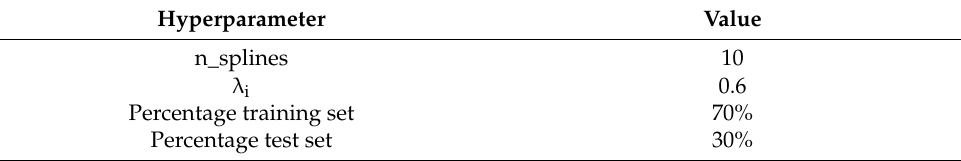
Table 3. Hyperparameter values .